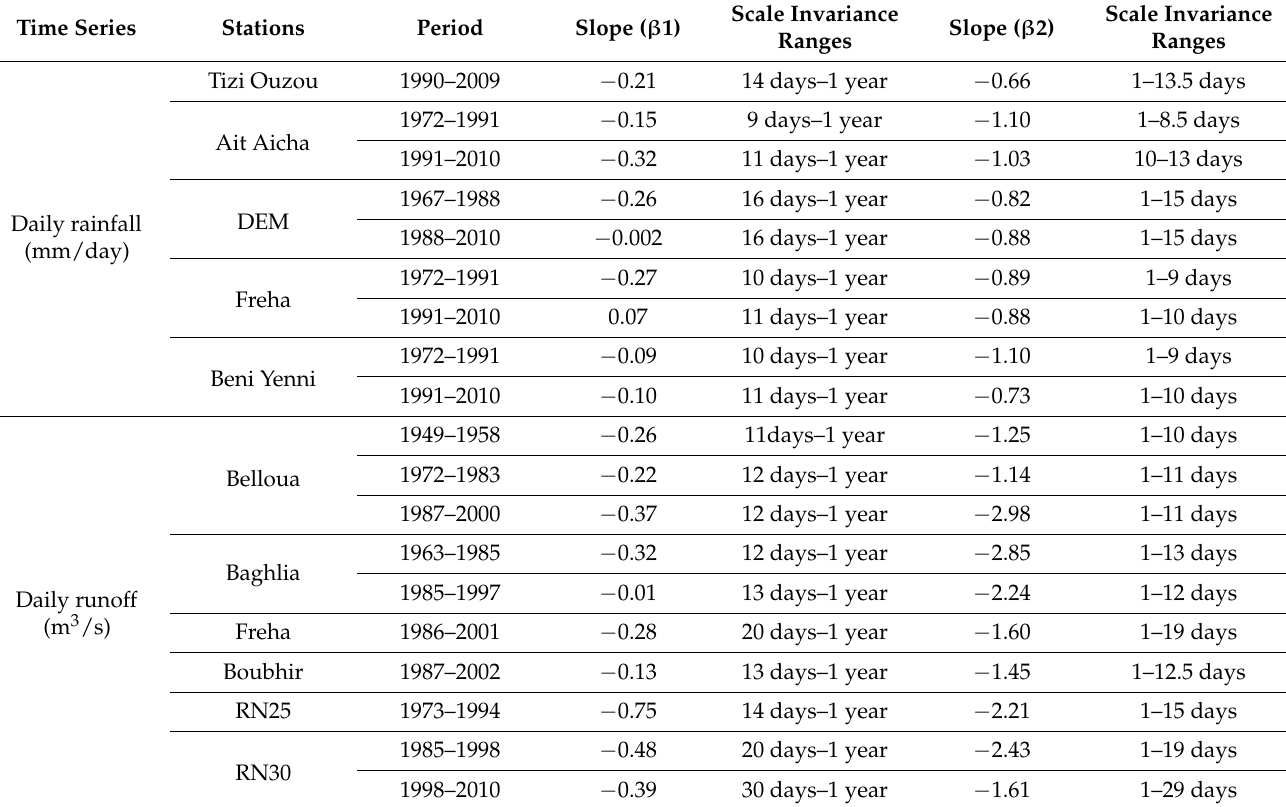
Table 3. Statistical fractals of the main hydroclimatic time series of the Sebaou River